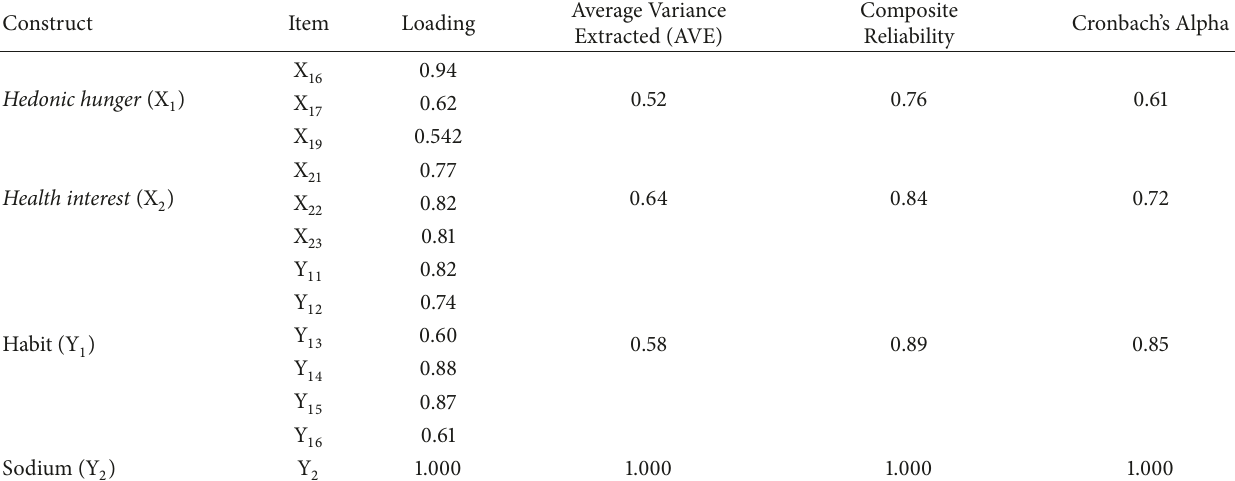
Table 3: Average Variance Extracted (AVE), Composite Reliability, Cronbach’s Alpha.